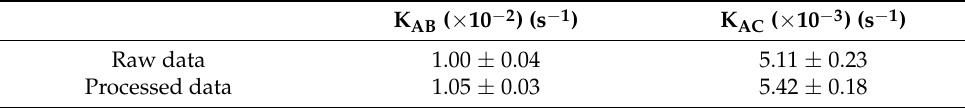
Figure 2. Dynamic metabolite signals and background noise in the simulations. The metabolite signal simulations of high-SNR and low-SNR are shown in ( a , b ). The black dots represent the high-SNR simulation. The blue dots and the green dots represent, respectively, the signal and background noise in the low-SNR simulation. The red dots represent the processed signals after using our method. The background noise is the same order of magnitude in both metabolites. ( a ) The reference, raw, and processed signals of metabolite B and the background noise. ( b ) The reference, raw, and processed signals of metabolite C and the background noise. Table 1. Apparent exchange rate constant results of the simulation